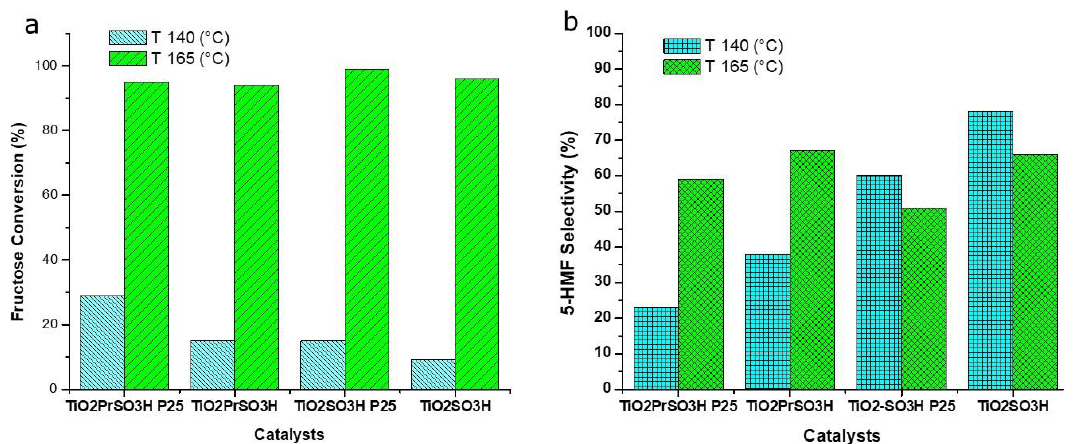
Figure 7. Fructose conversion ( a ) and 5-HMF selectivity ( b ) over acid TiO 2 catalysts. Reaction conditions: fructose 1.1M, 3 mL biphasic system 1:1 water / organic (3:7 sec-BuOH / MIBK), reaction time 3 h, catalysts 6 mg.